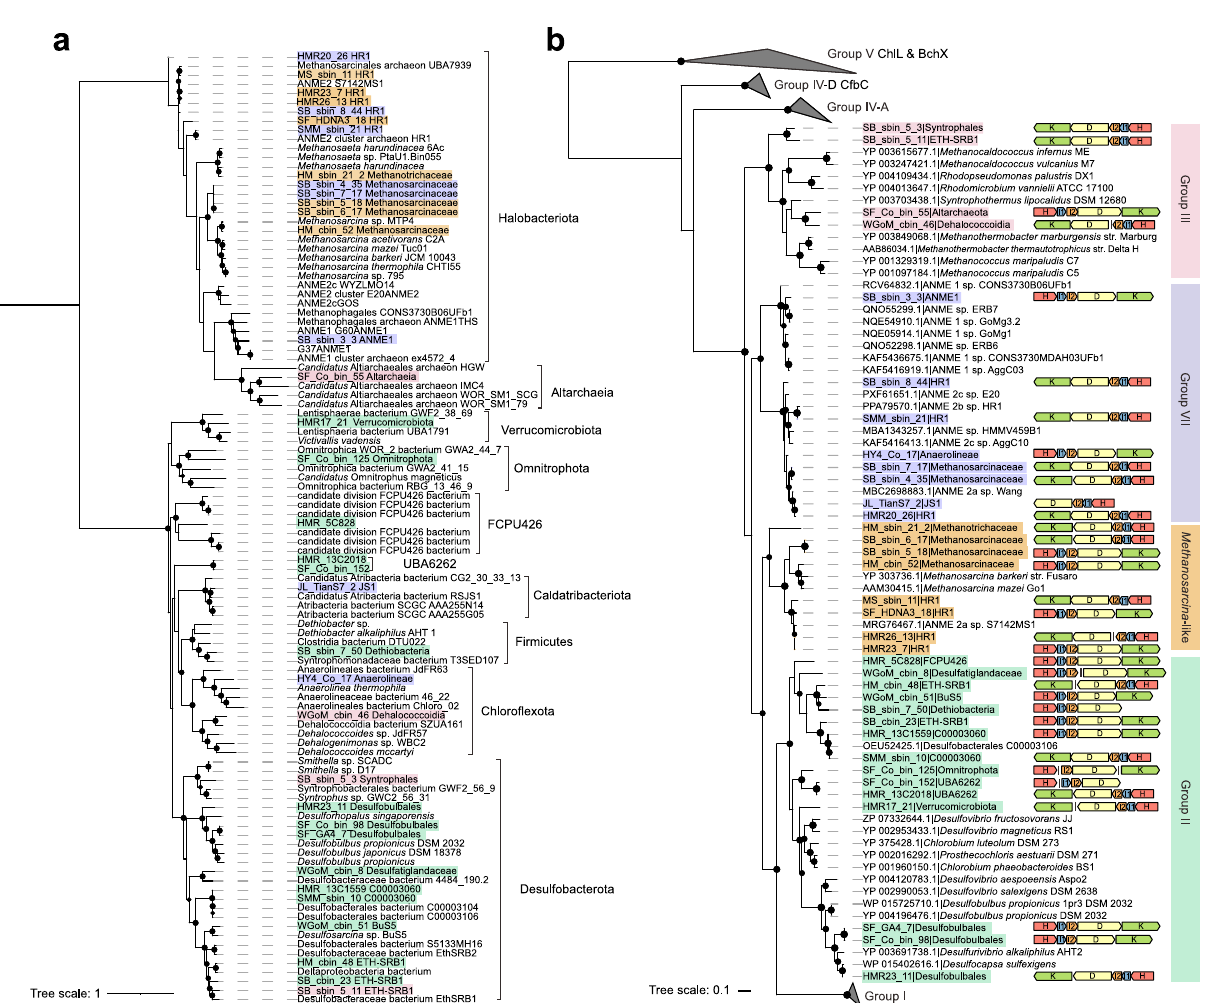
Fig. 4 | Maximum-likelihood phylogenetic trees of nitrogen- fi xing MAGs and their NifH protein sequences. a Phylogenomic analysis of 35 MAGs containing nitrogen fi xationgenes.Thismaximum-likelihoodtreeisbasedonconcatenationof 43 conserved protein sequences. MAGs are colored based on their phylogenetic af fi liation at the phylum level. b Phylogenetic analysis of identi fi ed NifH protein